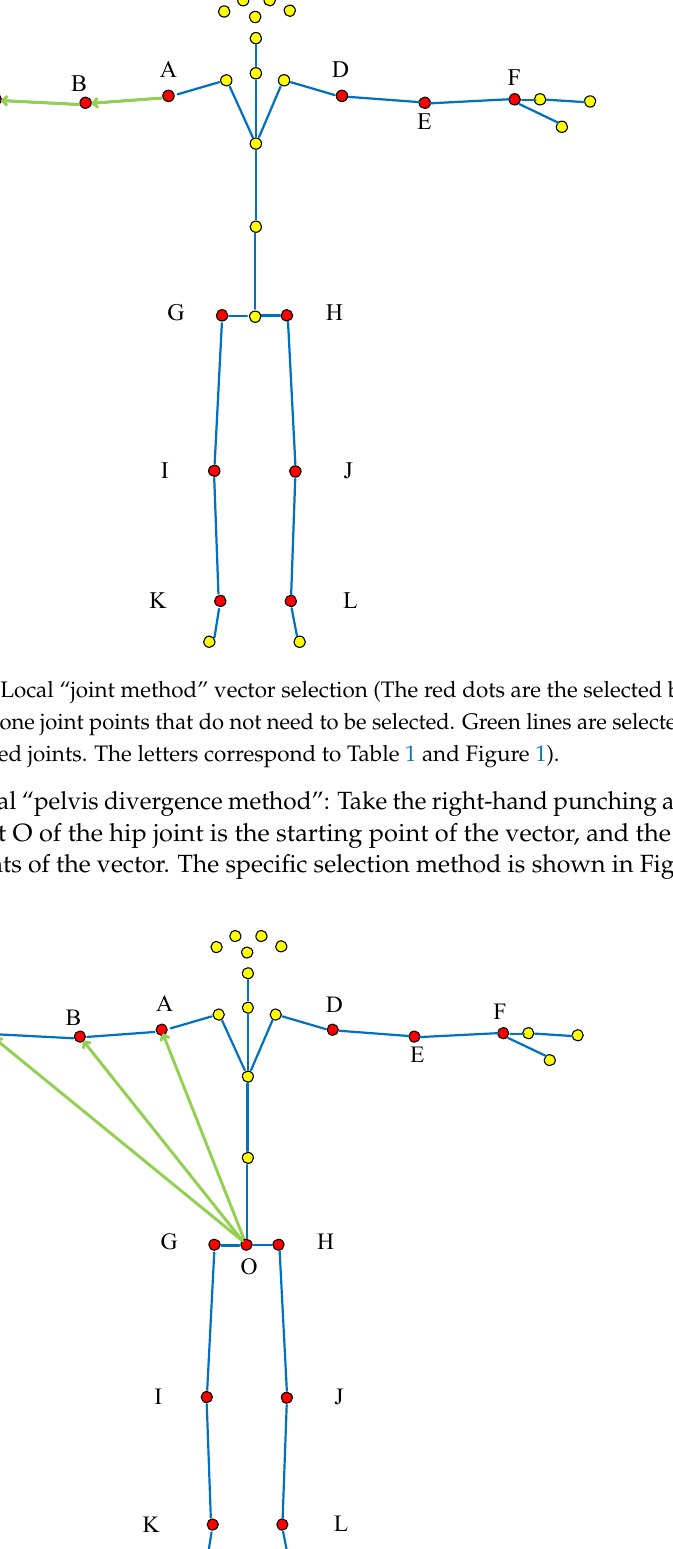
JO Figure 4. Overall “pelvis divergence method” vector selection (The red dots are the selected bone joint, and yellow dots are bone joint points that do not need to be selected. Green lines are selected